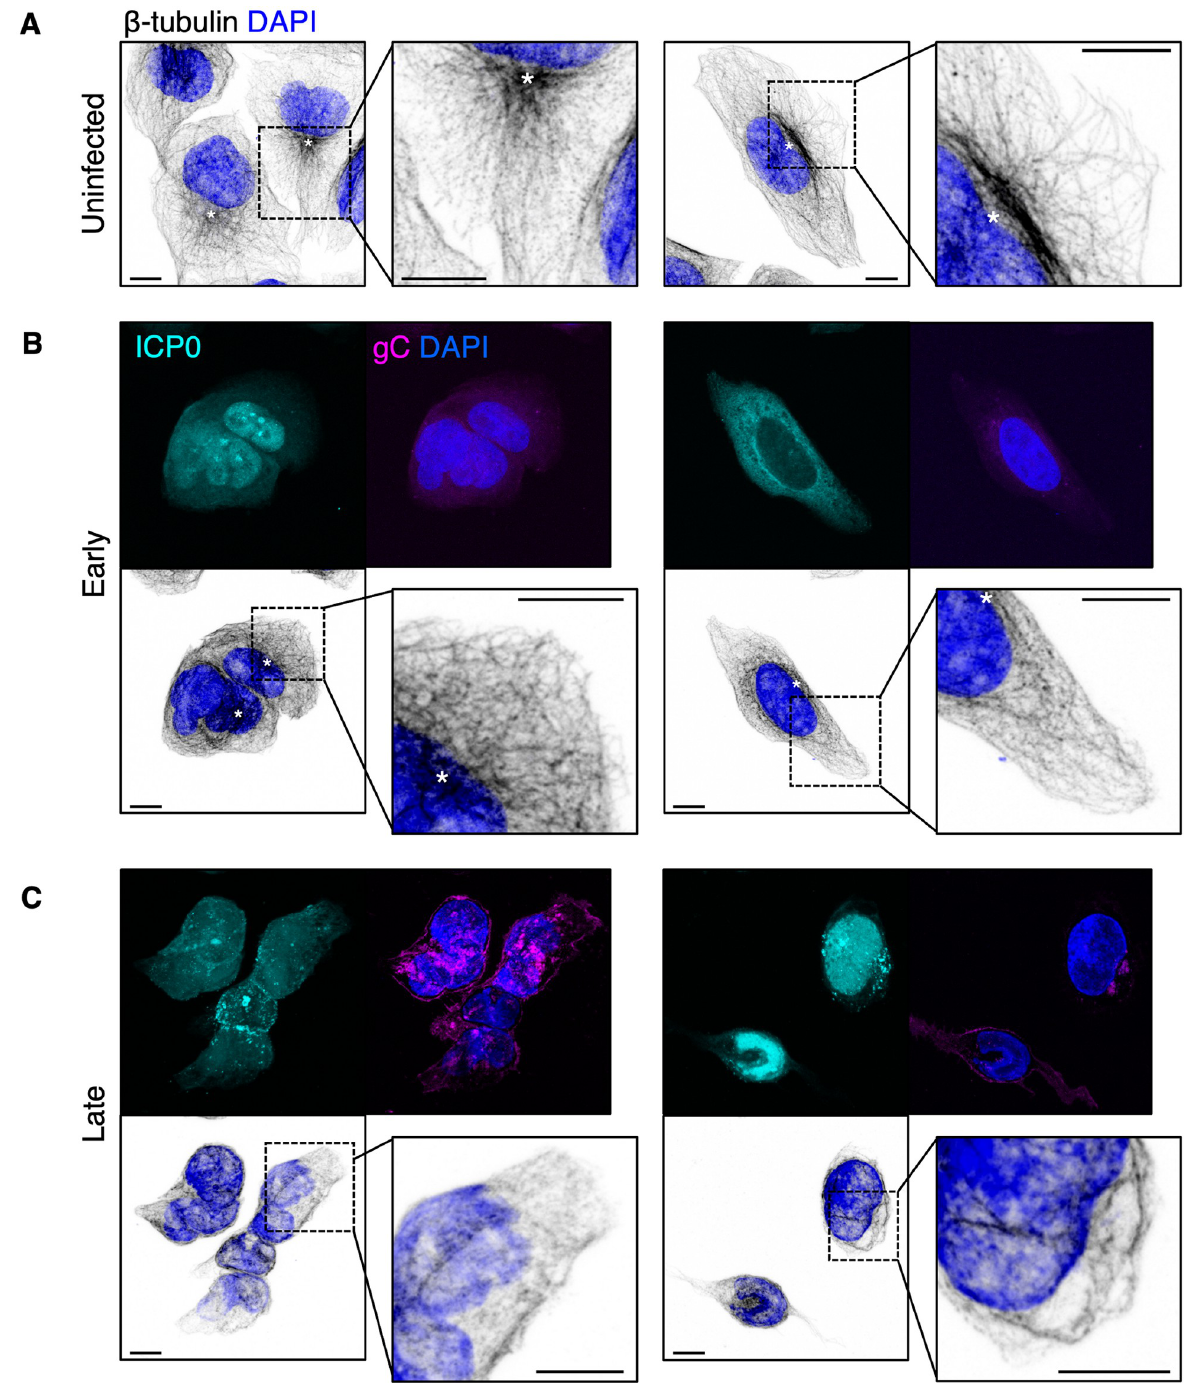
Fig 8. Remodelling of microtubules during HSV-1 infection. U2OS cells infected with timestamp HSV-1 were fixed at indicated times and imaged by confocal microscopy. β -tubulin immunolabelling was used to identify microtubules. Scale bars = 10 μ m. Putative microtubule organising centres (MTOCs) are indicated with asterisks ( � ). ( A ) Uninfected cells exhibited an outspread microtubule network with long filaments, largely radiating from a putative MTOC. ( B ) The microtubule network was closely packed in cells at early stages of infection (6 hpi). ( C ) In cells at late stages of infection (16 hpi), fewer long filaments were observed, the cells lacked noticeable MTOCs, and the network became very closely packed.